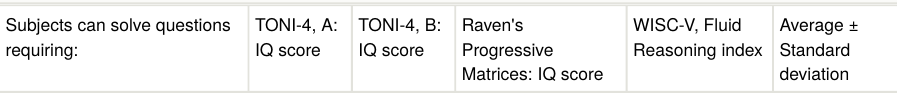
neurological mechanism. The corresponding raw score is indicated in square